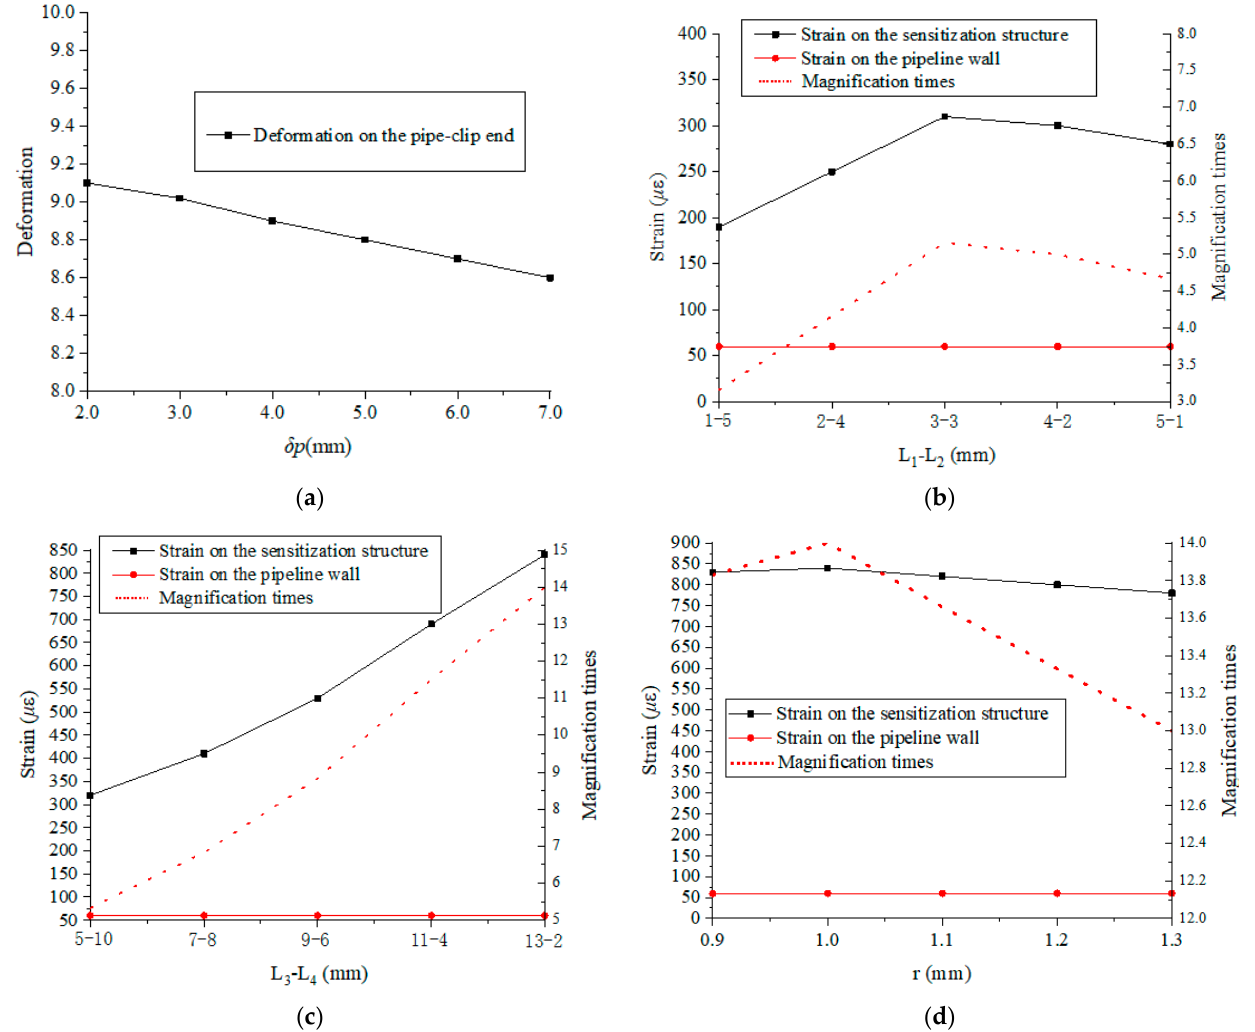
Figure 10. Sensitization changes with different parameters. ( a ) δ p , ( b ) L 1 -L 2 , ( c ) L 3 -L 4 , ( d ) r .